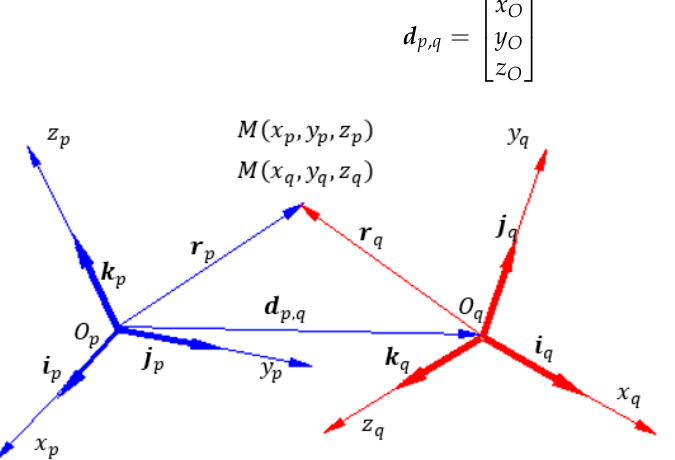
Figure 1. Expressing the position of a point M in two different coordinate systems.